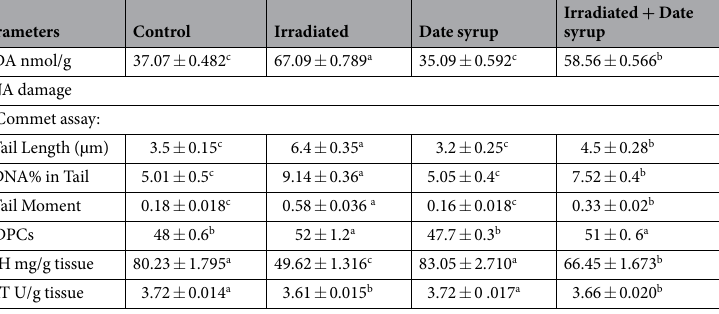
Table 2. Oxidant/antioxidant biomarkers in control and different groups. Values are presented as mean ± SE. Means in the same row followed by different letter superscripts are significantly different at (P <